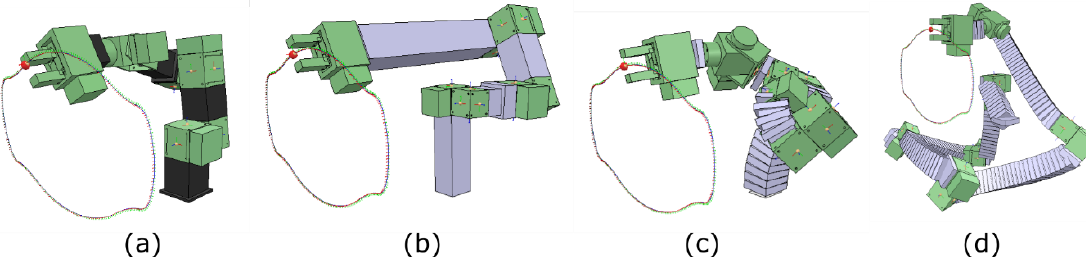
Figure 18. Best results for task 2: ( a ) basic links; ( b ) linear links; ( c ) rounded links; ( d ) Hermite spline links.